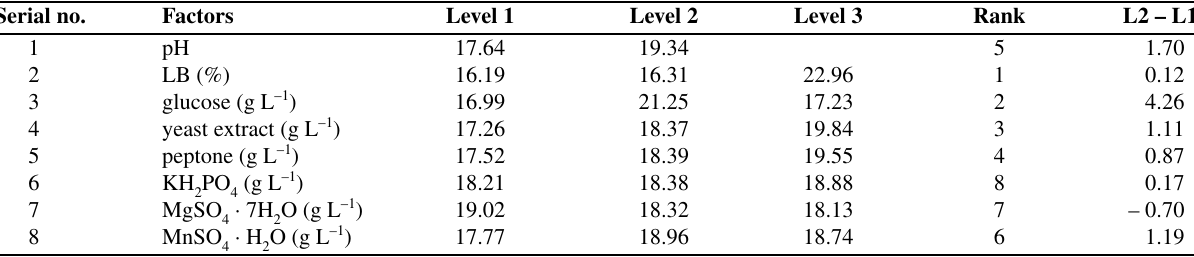
Table 3: Response table for mean values (“Larger is better”) Serial